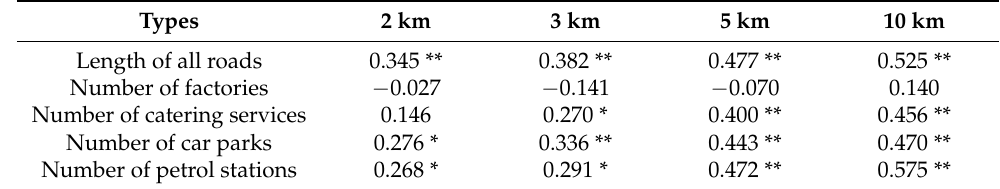
Table A2. Correlation coefficients between geographical elements of emission sources and PM 2.5 concentration at different buffer